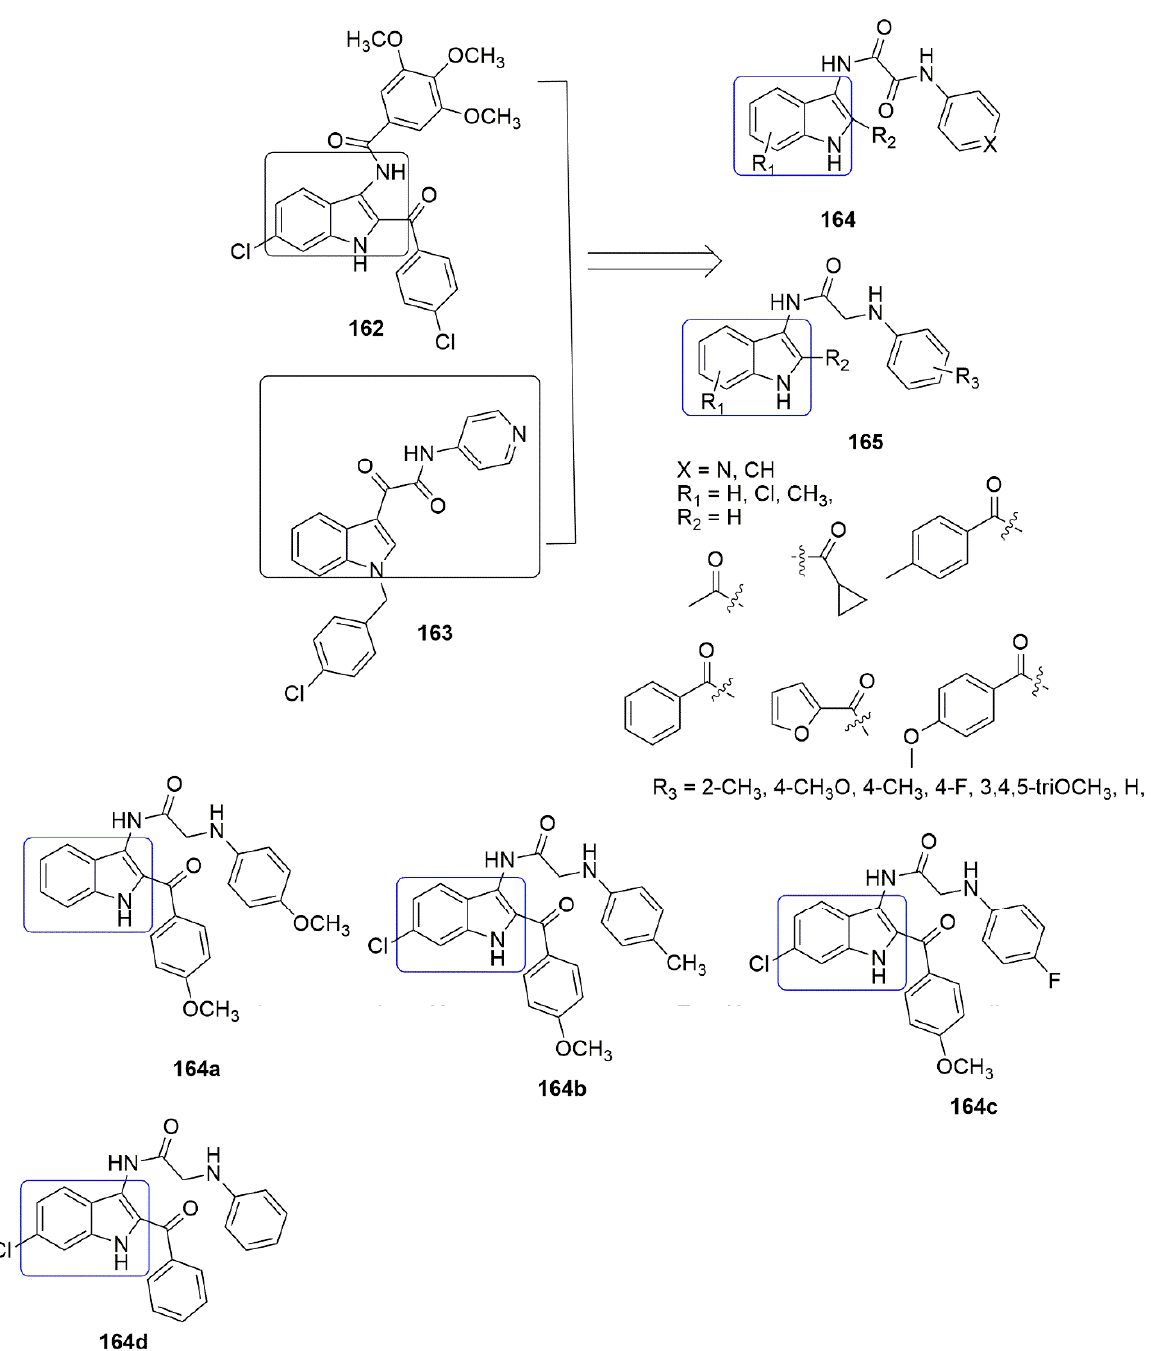
Figure 43. Novel indole-based oxalamide and aminoacetamide derivatives exhibiting anti-tubulin activity. The indole-1,3,4-oxadiazole ( 167 ) and indole-1,2,4-triazole ( 168 ) hybrids were synthe- sized in two series by replacing the imidazole scaffold of topsentin 122 . The synthesized compounds were further evaluated for their antiproliferative activity using 60 human can- cer cell lines panels. The 1,3,4-oxadiazole containing derivatives displayed superior activ- ity compared to 1,2,4-triazole derivatives. Among the compounds tested, compounds 167a , 168a , and 169b proved to have excellent inhibitory activity with IC 50 values of 2.42, 3.06, and 3.30 µM, respectively, against the MCF-7 human cancer cell line compared to the reference drug doxorubicin ( IC 50 value = 6.31 µM). Of all cancer cell lines, the colon (HCC- 2998) and breast (MCF-7, T-47D) cancer cell lines were found to be more vulnerable to this class of compounds. The SAR analysis showed that aryl substitution on the rings